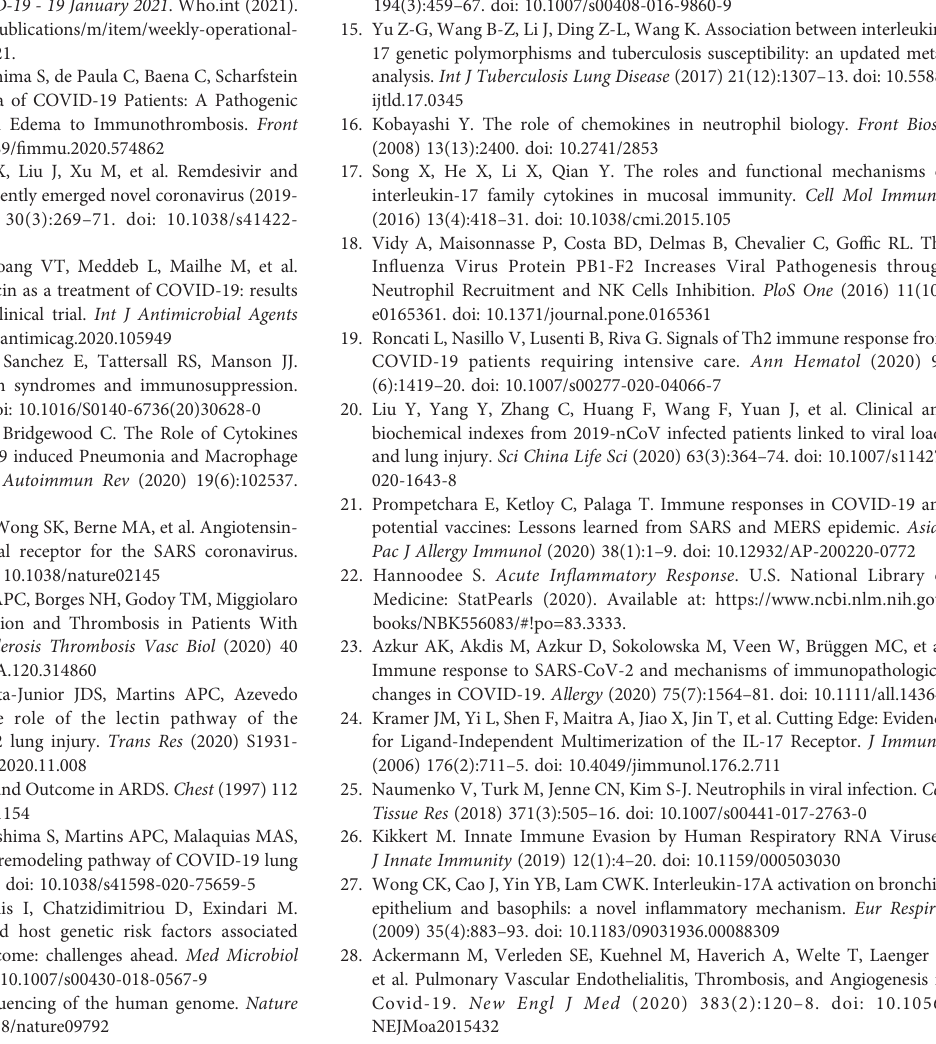
Supplementary Figure 1 | Lung sample H&E stained (COVID-19 patient) showing alveolar spaces (black circle) with numerous hyaline membranes (black asterisk) and scarce neutrophilic exudation in the alveolar septa (black arrow). The H1N1pmd09 lung sample shows scarce hyaline membranes (black asterisk) in the alveolar spaces (black circle) and numerous neutrophils in the alveolar septa (black arrow). Lung samples of both groups (COVID-19 and H1N1) showing septal lymphocytesexpressingIL-8andIL-17A(blackarrow),scarceintheCOVID-19lung sample and numerous in the H1N1pdm09. In H1N1pdm09 samples is observed numerous lymphocytes expressing IL-17A intermixed with numerous neutrophils and macrophages. Supplementary Figure 2 | Graphical abstract showing the neutrophil recruitment triggered by